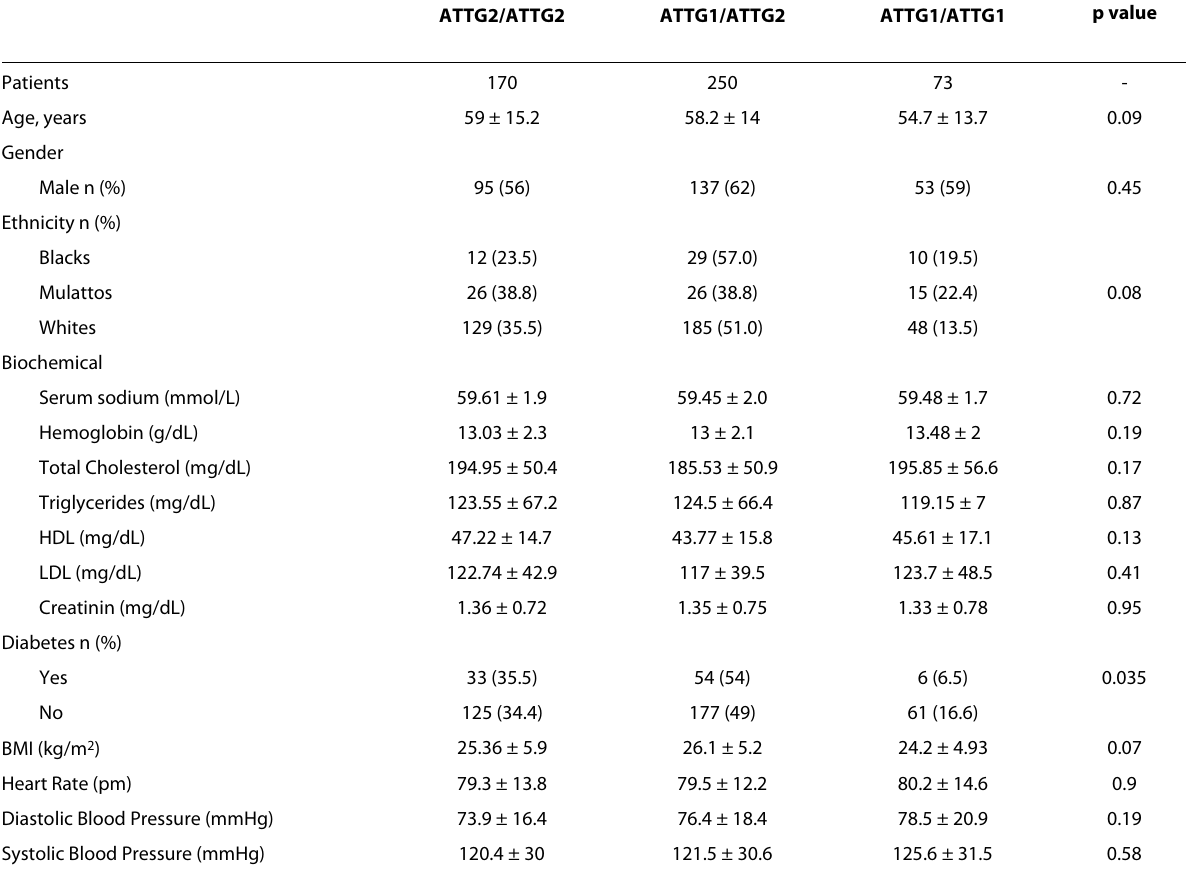
Table 2: Demographic and clinical characteristics of the HF population according to -94 insertion/deletion genotype.